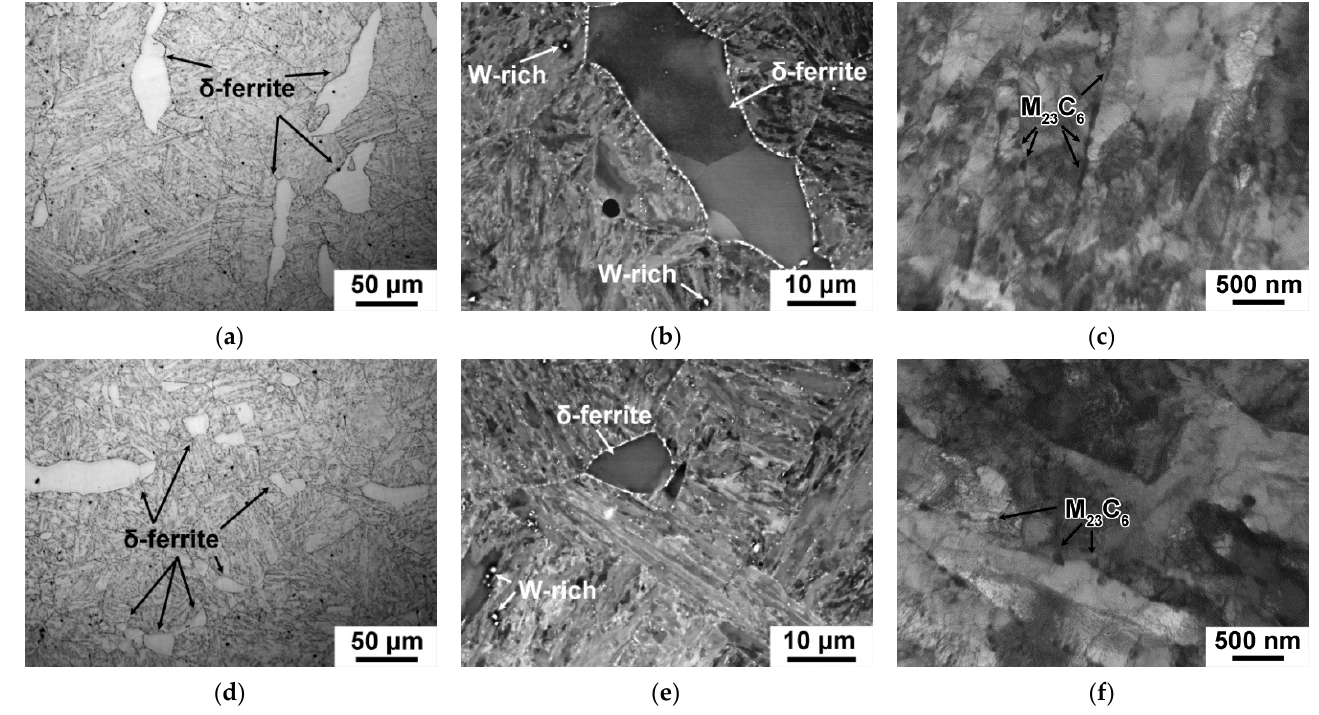
Figure 10. Typical microstructures in the 12CrTaNb0.02N steel subjected to the CHT ( a – c ) and TMP ( d – f ) obtained by optical metallography ( a , d ), SEM ( b , e ), and TEM ( c , f ).